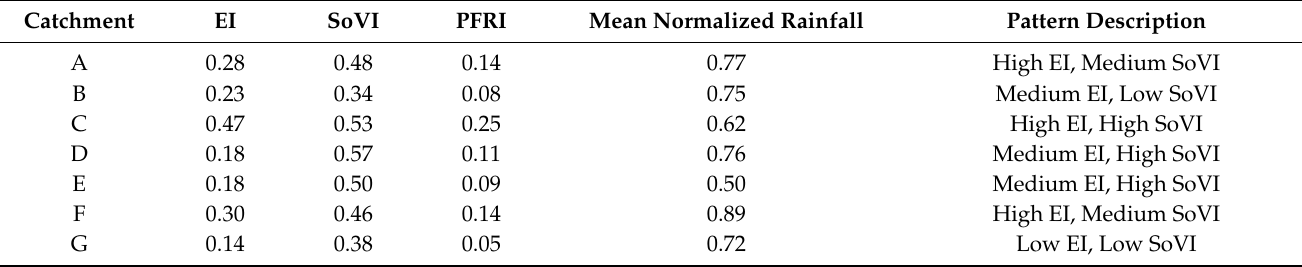
Table 5. Summary of the case analysis of seven flooded